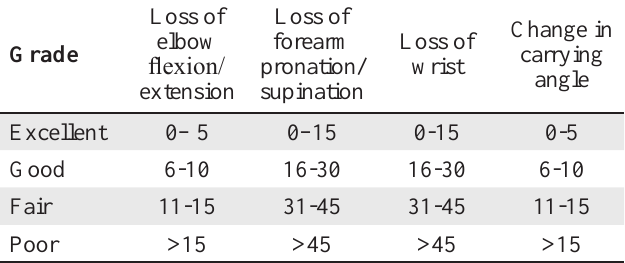
Table 1 : The modified Flynn classification (all measurements in degrees compared with normal un-injured limb; the largest deficit for movement in each plane is taken for assigning a clinical